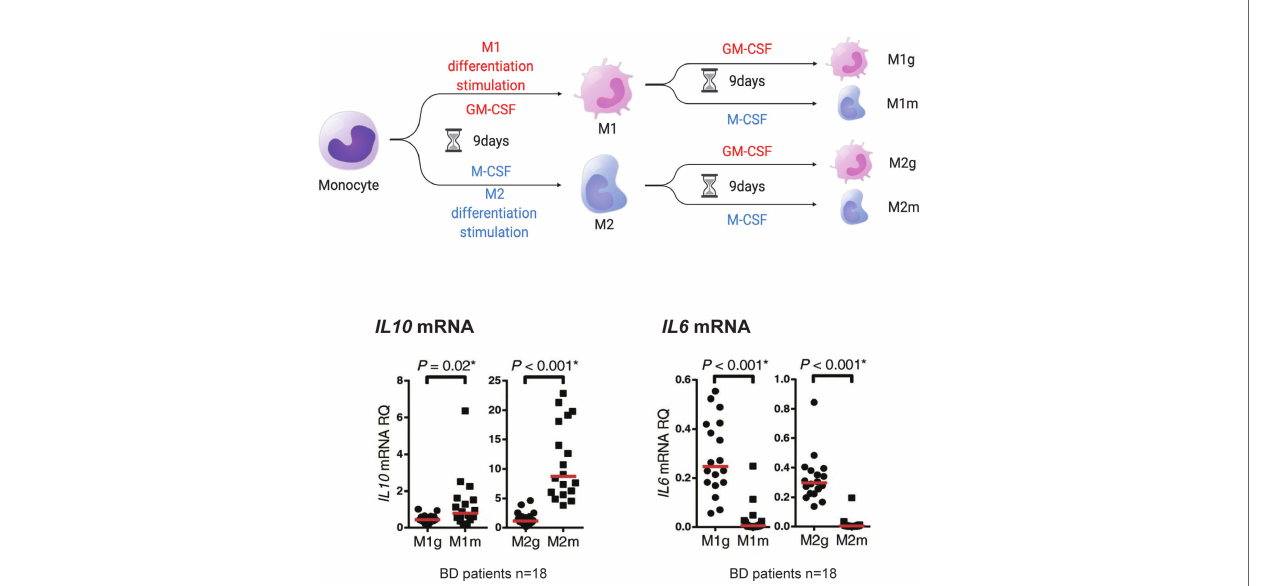
FIGURE 3 | M1 and M2 macrophages may be interchangeable. Monocytes (mono) treated in vitro with GM-CSF (M1g and M2g) or M-CSF (M1m and M2m) for 9 days developed an M1 or M2 macrophage-like phenotype (de fi ned here as M1 or M2 stimulation). However, the M2 macrophages stimulated with “ M2 ” or “ M1 ” stimulation for another 9 days (the fi rst M1 stimulus followed by M2 stimulus is de fi ned as “ M2g ” and the second M1 stimulus followed by M2 stimulus is de fi ned as “ M1m ” ) maintained or decreased IL10 mRNA production. IL6 mRNA production was reduced by M2 stimulation of M1 macrophages. This fi gure is a modi fi ed version of Figure 4 a-e published in Nakano et al. (37). The fi gure is modi fi ed and distributed under the Creative Commons Attribution 4.0 International License (CCBY4.0, http://creativecommons.org/licenses/by/4.0/). This fi gure was partially created by